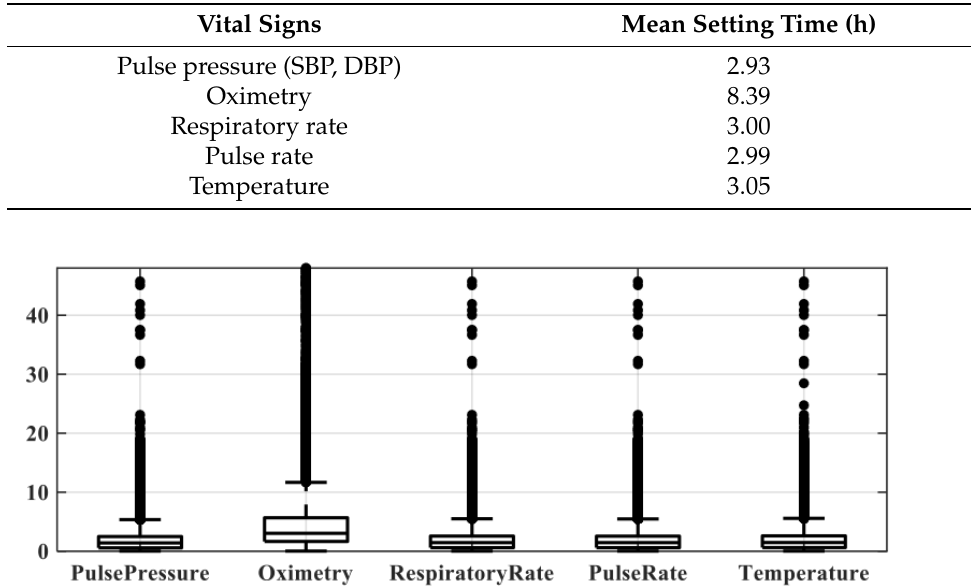
Table 8. Mean setting time for vital signs.